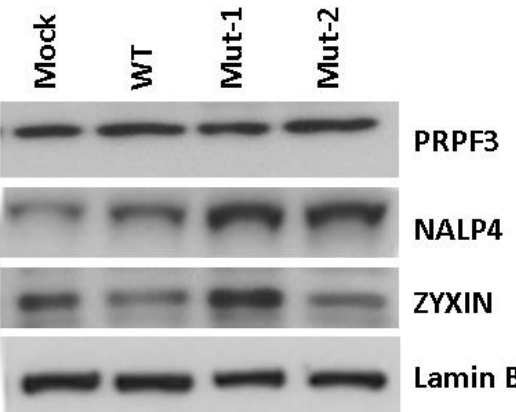
Figure 3. Experimental confirmation of the nuclear protein changes with hMPV infection. Total nuclear fractions prepared from A549 cells uninfected or infected with rhMPV (MOI of 2) were resolved on 10% SDS-PAGE and Western blot was performed using antibodies against PRPF3, NALP4, and zyxin. Membranes were stripped and reprobed for Lamin B as an internal control for protein integrity and